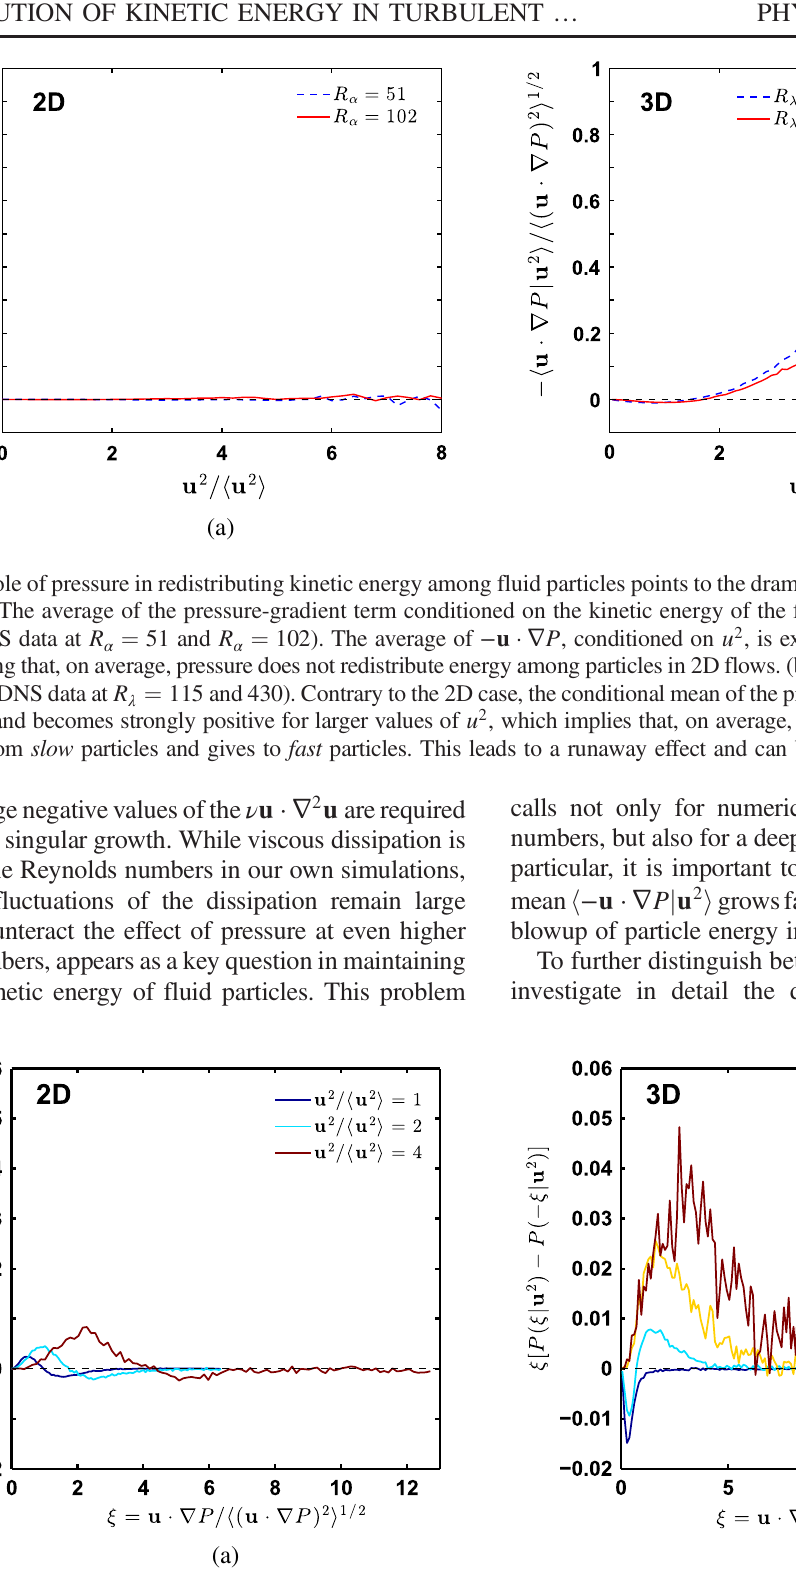
FIG. 4. The contribution of different values of ξ ≡ − u · ∇ P= hð u · ∇ P Þ 2 i 1 = 2 to the conditional average h − u · ∇ P j u 2 i , at different values of u 2 . (a) 2D turbulence at R α ¼ 102 and (b) 3D turbulence at R λ ¼ 430 . The quantity shown is the difference between the PDF of positive and negative values of ξ , multiplied by ξ , so h − u · ∇ P j u 2 i is simply the integral of the curves shown in the figure. The quantity shown in 2D is generally much smaller than in 3D. Also, at large values of u 2 in 2D, the very large values of ξ tend to decelerate particles. In 3D, on the other hand, all values of ξ contribute to transfer energy to fast particles.